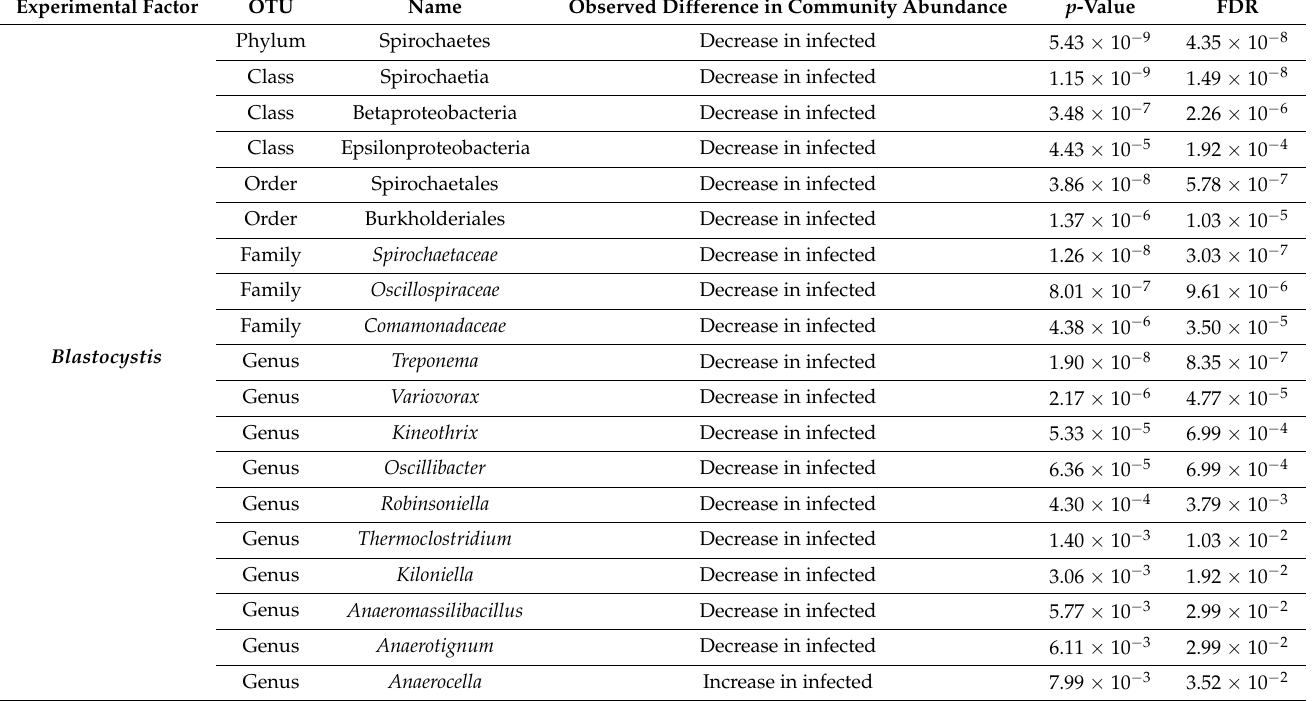
Table A5. Significant OTUs identified by MetagenomeSeq as differentially abundant between B + and B - samples ( p < 0.05). A total of 19 significant results were identified here, the observed difference in community abundance summarises the observed change between B + and B - for each OUT.